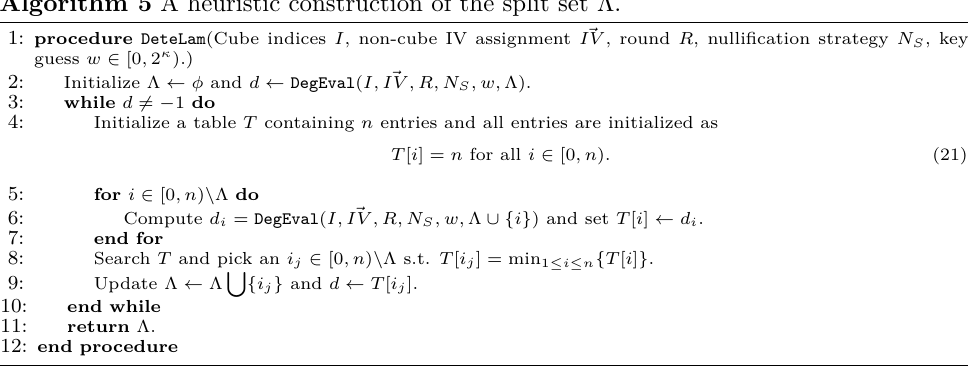
Algorithm 5 A heuristic construction of the split set